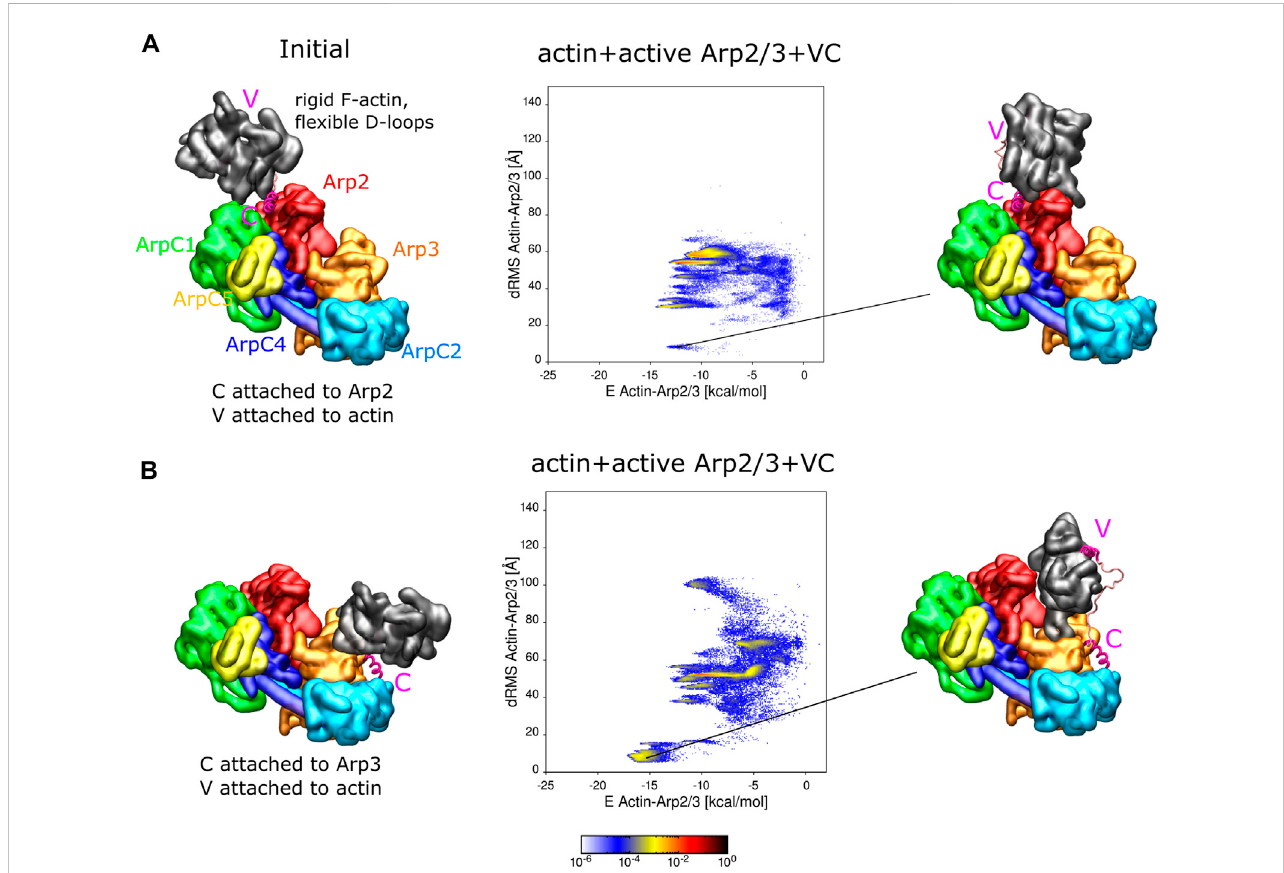
FIGURE 4 Actin binding to active Arp2/3 complex with attached VC domain. (A) REMD simulations of actin delivery to Arp2 of inactive Arp2/3 complex. Actin and Arp2/3complexareconnectedbytheVCdomain,withVrigidlyattachedtoactinandCdomainrigidly attachedtotheArp2-ArpC1site.Theactin monomeris in the rigid F-actin conformation with fl exible D-loop. Left: Initial conformation with actin separated from Arp2/3 complex. Middle: 2D-distributions of dRMS vs. binding energy are calculated and plotted in bins of .1 kCal/mol × .5 Å. Right: Example of conformation are randomly selected from the lowest dRMS hotspot. (B) Same as panel (A) but with C domain attached to the Arp3 site. Simulations performed in cubic boxes of sides 300 Å for (A) ~ 1 . 7 μ s, and (B) ~950